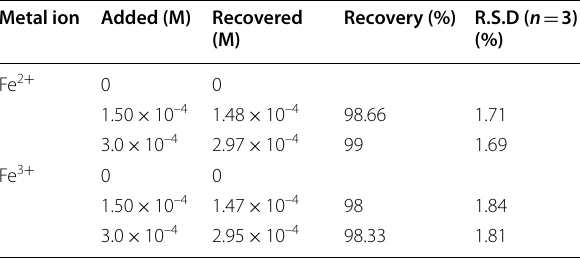
Table 1 Determination of Fe 2 + . and Fe 3 + in water samples Metal ion Added (M) Recovered